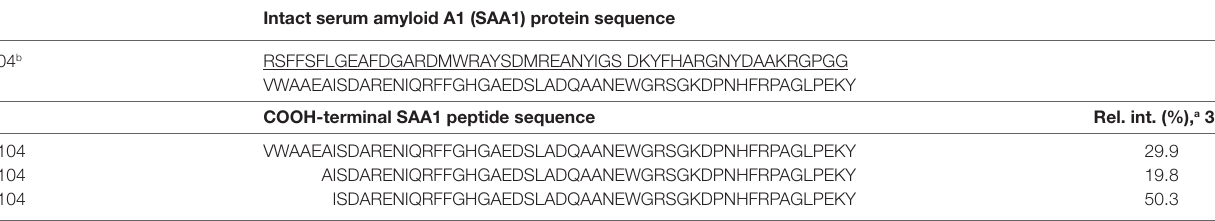
TaBle 1 | Mass spectrometric analysis of the cleavage sites of matrix metalloproteinase-9 (MMP-9) in intact recombinant SAA1 α